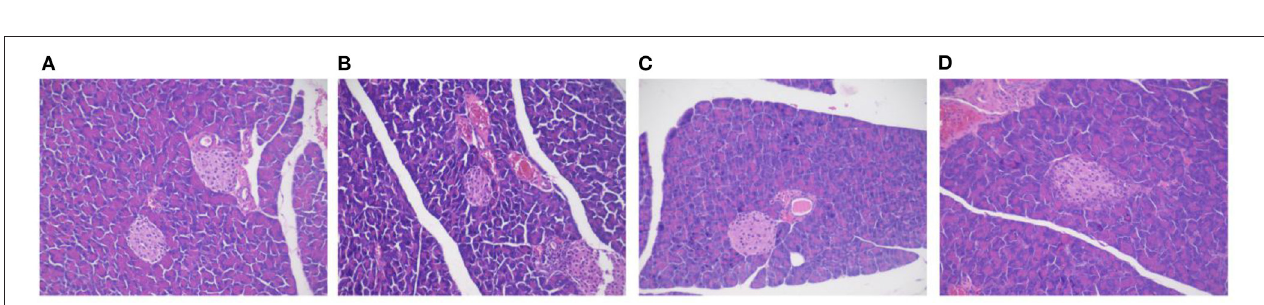
FIGURE 6 | Effects of MBPs on (A) SOD levels and (B) MDA levels. Data were presented as the mean ± SD ( n = 6). ** P < 0.01, NCD compared with HFD mice. ## P < 0.01, HFD compared with HFD + MBPs mice.